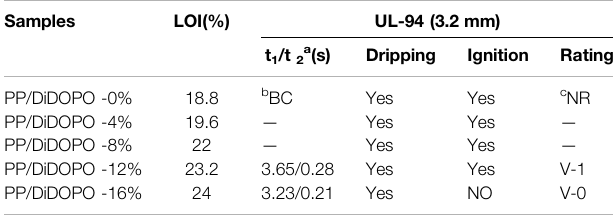
TABLE 1 | UL-94 and LOI test results of PP/DiDOPO conjugated fl ame retardant composites.